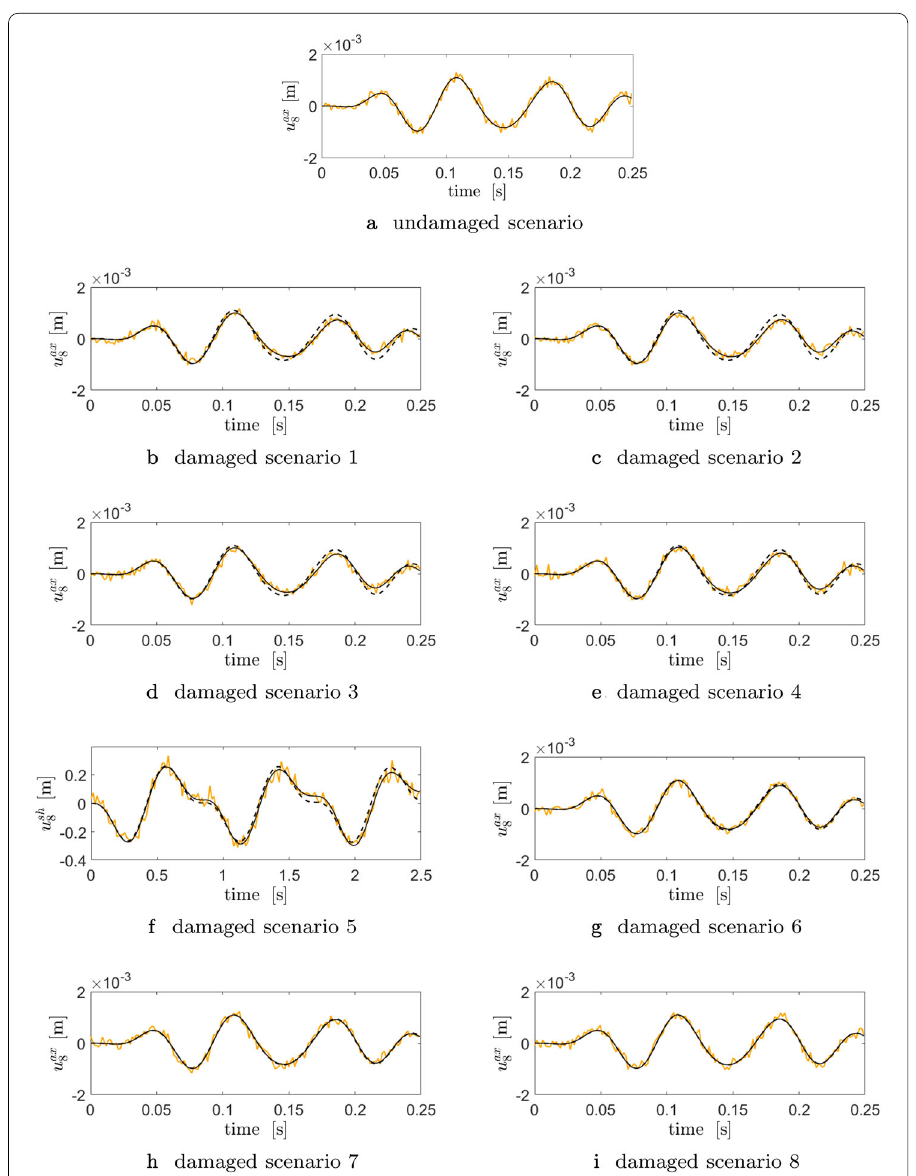
Fig. 10 Examples of time evolutions of displacements in the z direction of the 8-th story for SNR = 10 dB, = (15 . 5 , 22 . 0), γ ax = (1 . 133 , − 1 . 140), in the undamaged scenario ( a ) and all possible damage with f ax 1 , 2 1 , 2 scenarios ( h – i ). Orange lines represent u , whereas black lines stand for r , according to Eq. (2). To show the effects of damage on the structural dynamics, the black dotted lines in h – i report the noise-free structural dynamics related to the undamage scenario